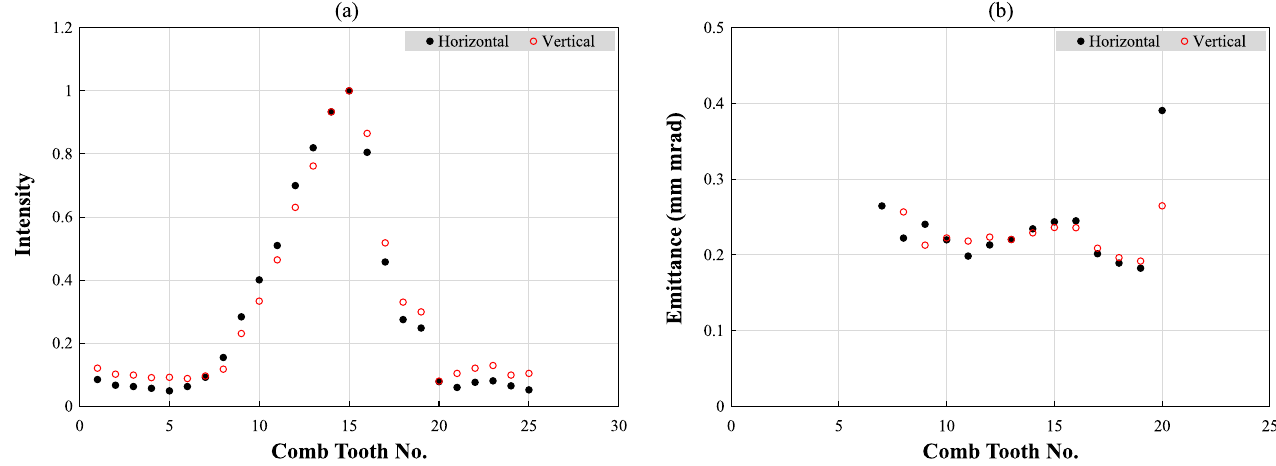
FIG. 16. Calculated beam parameters from the phase space data in Fig. 15. (a) Normalized intensities. (b) Emittance values. In (b), only the data from valid measurements (with sufficient intensities) are